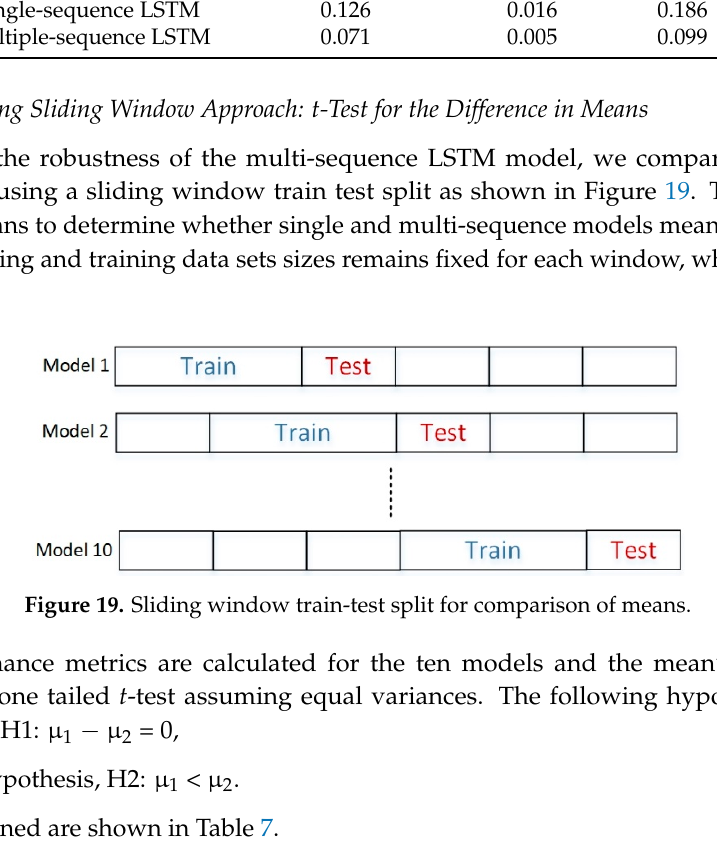
Table 7. t -Test for the difference in means: Sliding window approach.